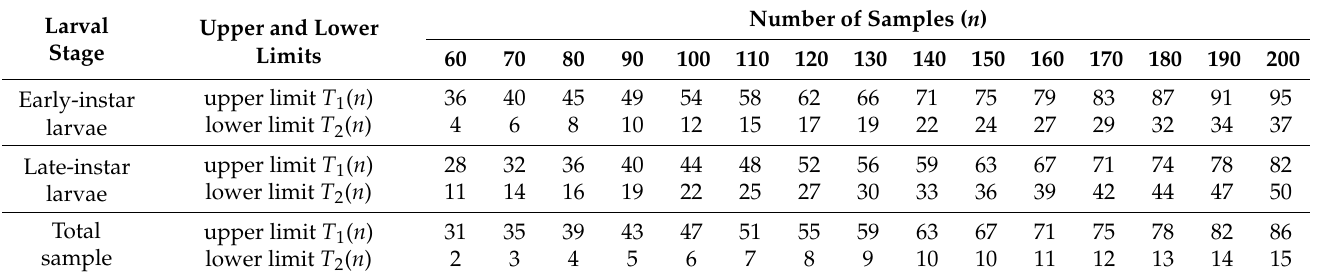
Table 7. The sequential sampling number of S. frugiperda larvae in maize fields in